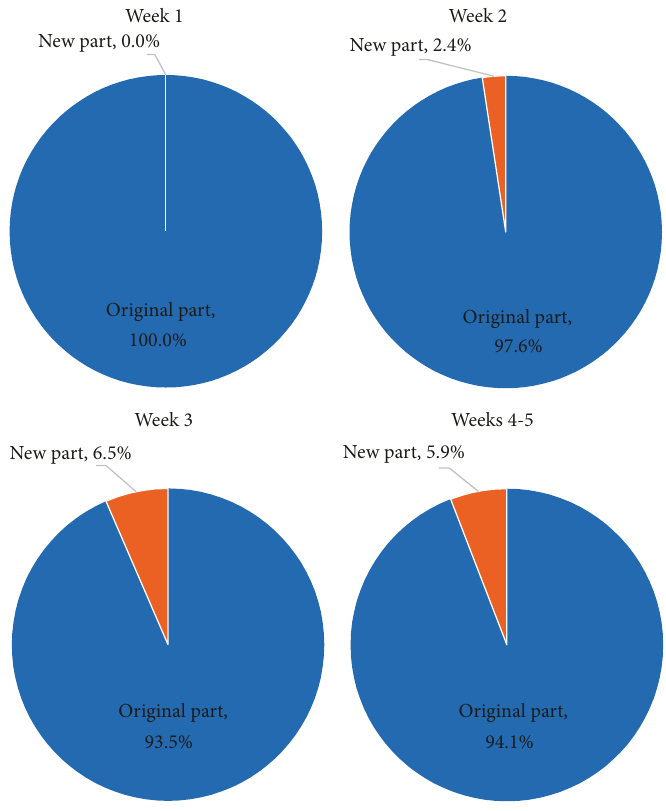
Figure 7: General weekly enclosure use (daytime observations) to compare how the females’ enclosure use changed throughout the study.